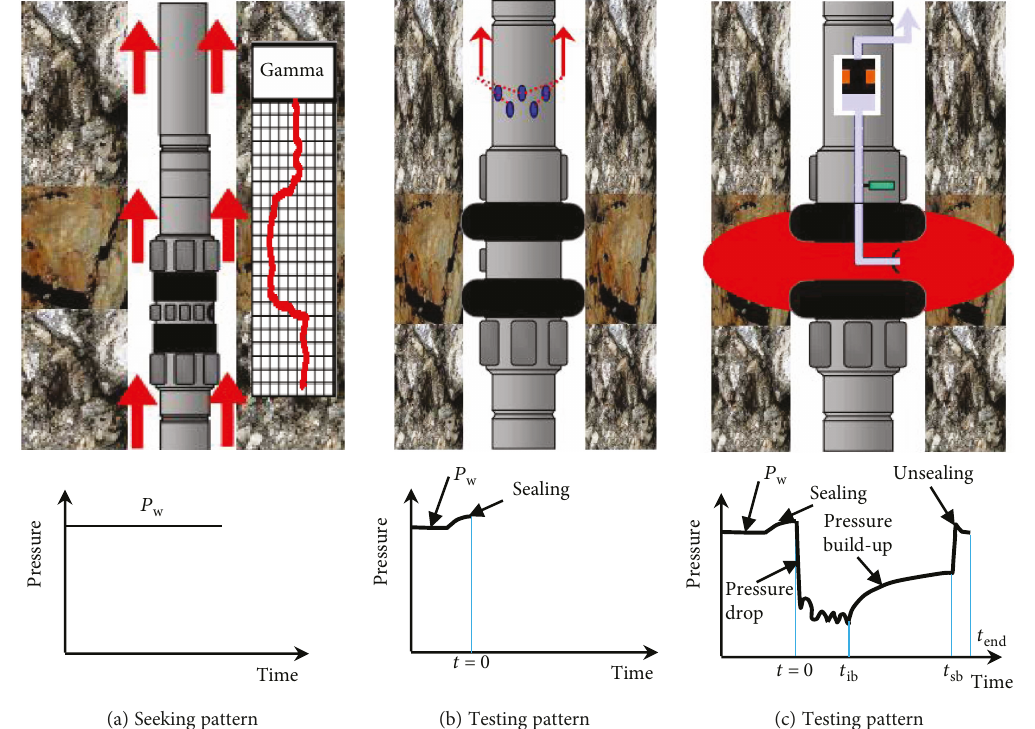
Figure 1: Testing principle of Drilling Formation Tester (DFT) (reproduced from [30]). (a) Seeking pattern (location by using gamma logging). (b) Testing pattern (setting packer to seal). (c) Testing pattern (pressure drop and buildup